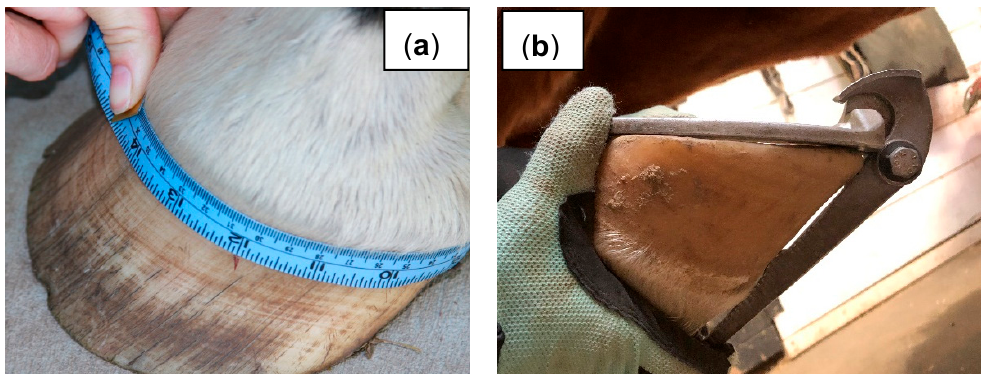
Figure 2. Measuring proximal hoof circumference ( a ) and hoof angle ( b ).